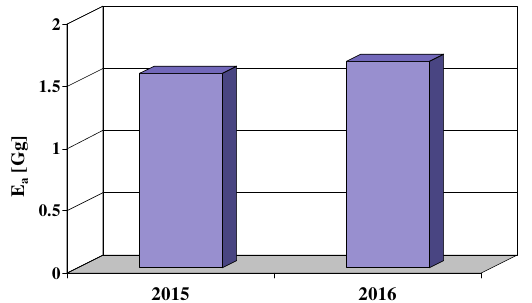
Fig. 9. National annual emission of particulate matter PM10 from motor vehicles in 2015 and 2016